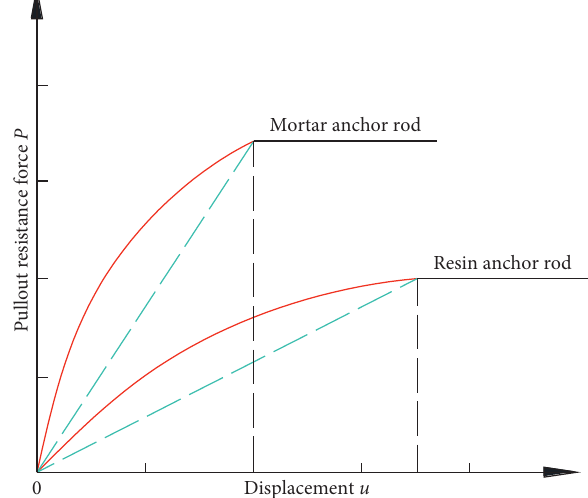
Figure 4: Displacement curves of resin anchor and mortar